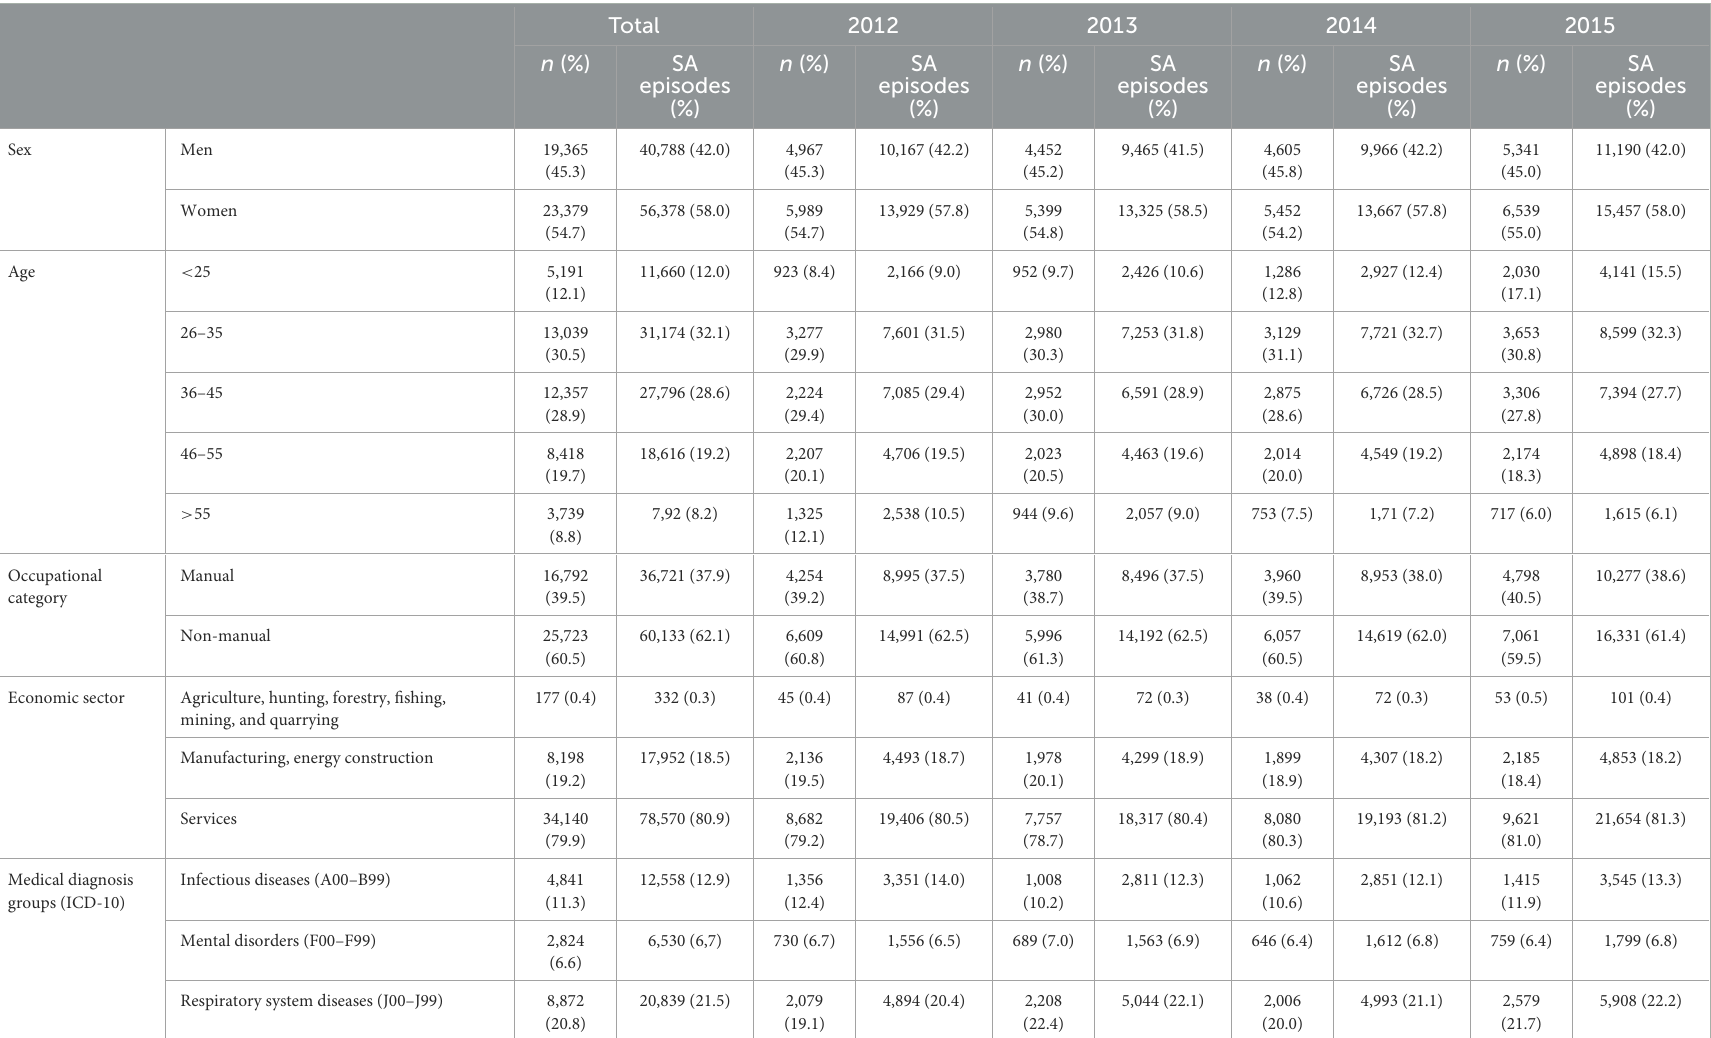
TABLE 1 Distribution of a sample of salaried workers residents in Barcelona who had a sickness absence (SA) episode in Barcelona between 2012 and 2015 by sex, age, occupational category, economic sectors, and medical diagnosis. Total